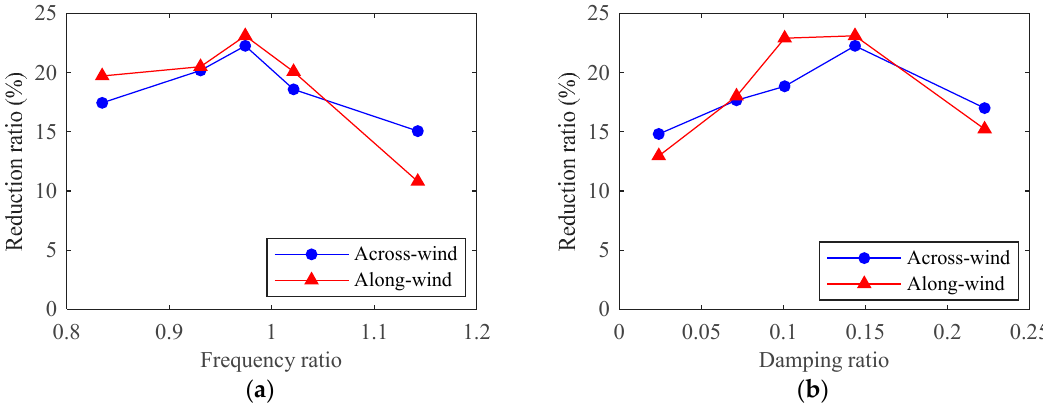
Figure 14. Variation of reduction ratios with ECTMD parameters under wind speed of 24.7 m/s and wind direction angle of 0°. ( a ) Variation of reduction ratio with frequency ratio of ECTMD; ( b ) Variation of reduction ratio with damping ratio of ECTMD.